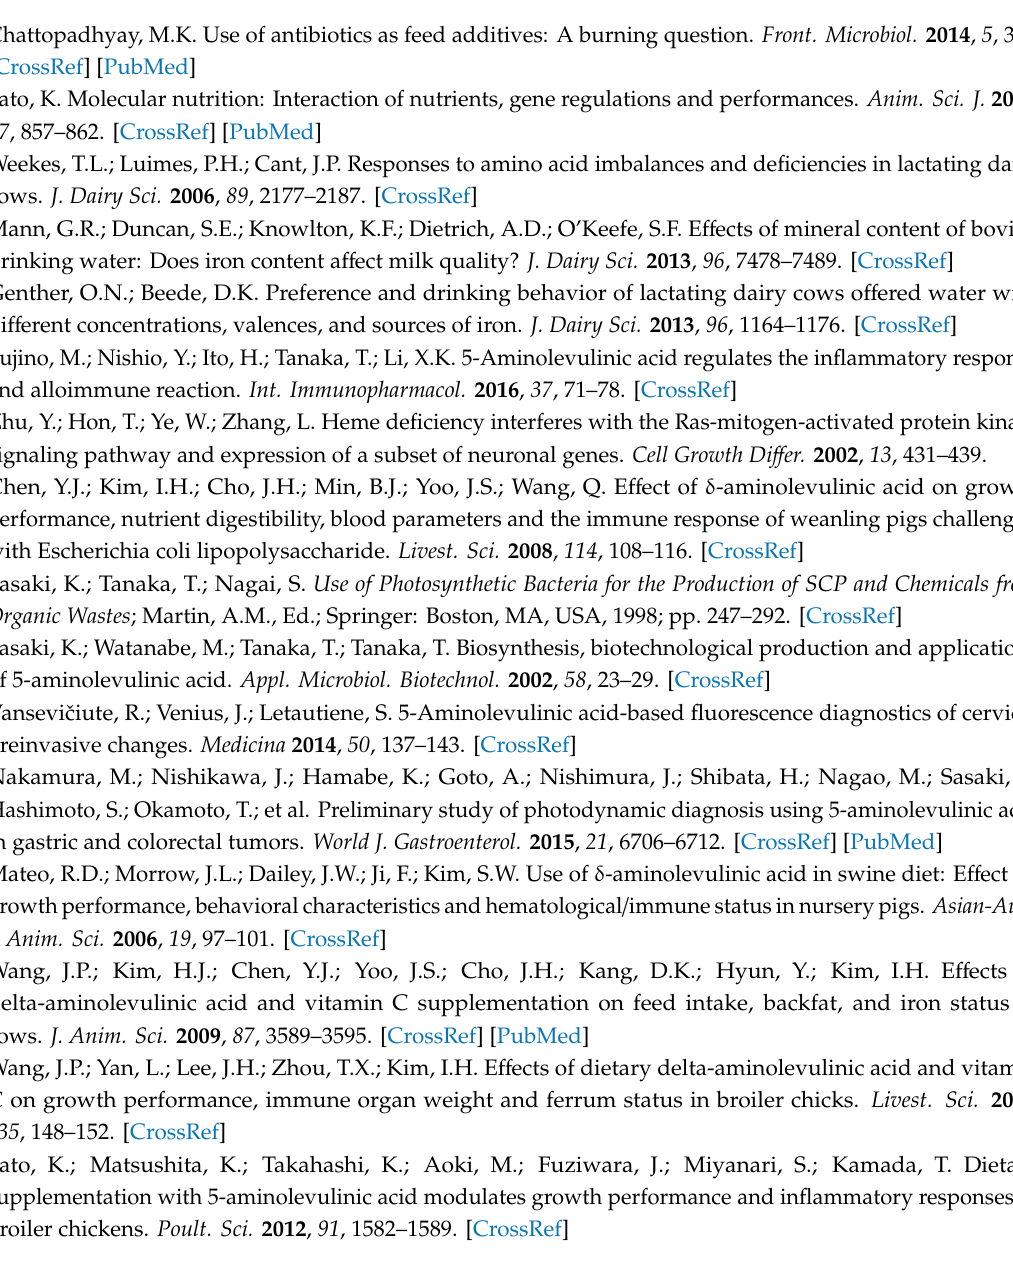
Table S1: Summary of the general data of papers evaluating the e ff ect of 5-ALA supplementation on farm animals. Table S2: Evaluation of the quality of the papers according to the selection criteria. Table S3: E ff ects of 5-aminolevulininc acid compared with other alternative treatments, and 5-aminolevulininc acid combination with other